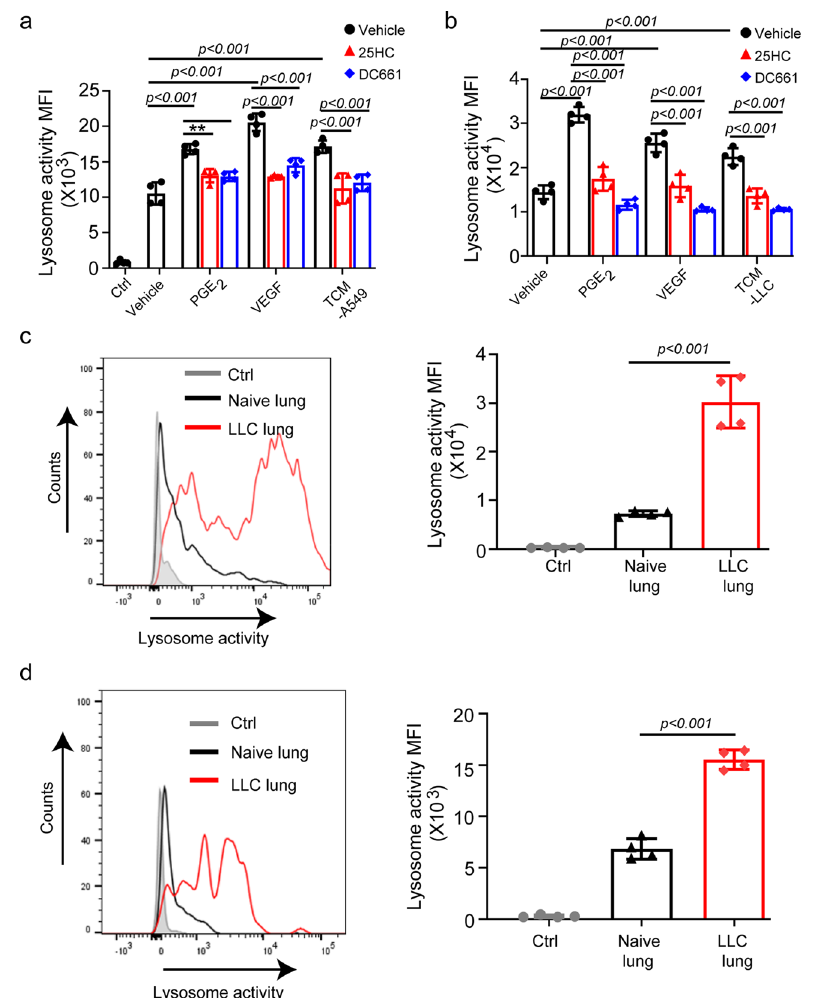
Fig. 4 | CH25H expression in DCs acts to limit the lysosomal degradation otherwise induced by factors of tumor microenvironment. a Quantitative ana- lysis of DQ-OVA fl uorescence in human CD14 + monocytes pretreated with PGE 2 (10ng/mL), VEGF (20ng/mL) or TCM from A549 cells (75%, v/v) for 24h with or without the treatment of 25HC (4 µ M) or DC661 (100nM). n =4 biologically inde- pendent samples. b Quantitative analysis of DQ-OVA fl uorescence in bone marrow derived DCs pretreated with PGE 2 (10ng/mL), VEGF (20ng/mL) or TCM from LLC cells (75%, v/v) for 24h with or without the treatment of 25HC (4 µ M) or DC661 (100nM). n =4 biologically independent samples. c Representative histogram and quantitative analysis of DQ-OVA fl uorescence in total DCs (CD45 + CD11c + MHC II + )